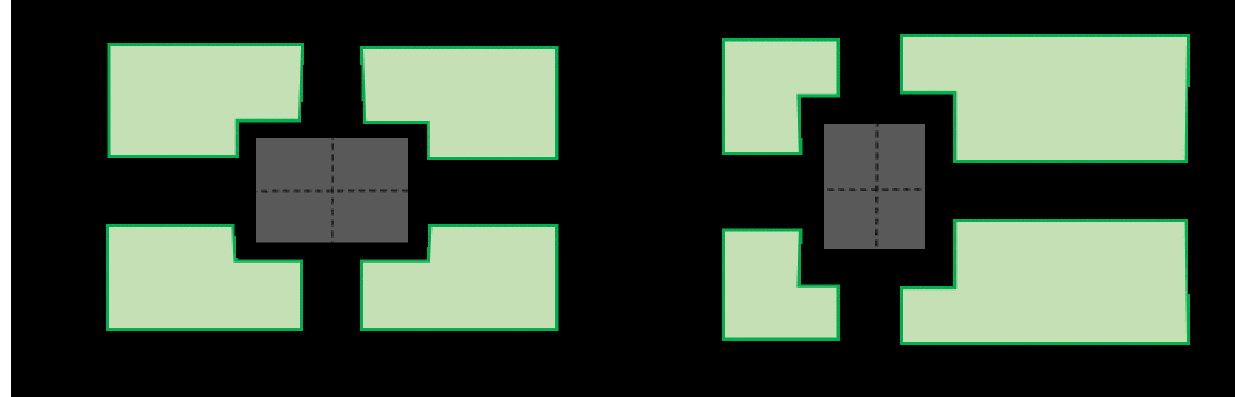
Figure 8. Schematic patterns of belvederes location in Persian gardens. ( Source: author